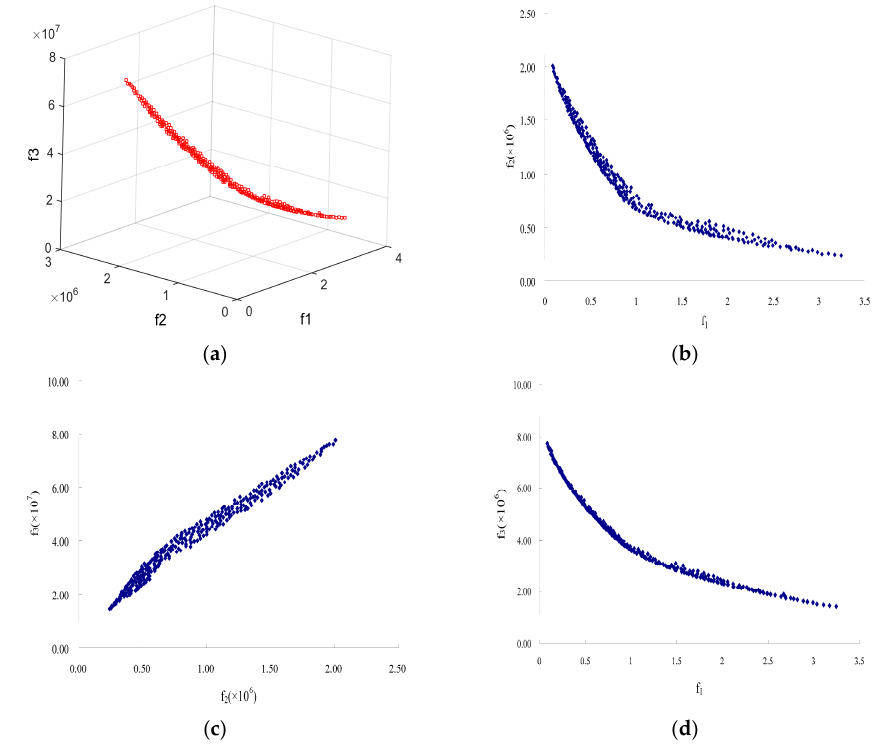
Figure 2. ( a ) The Pareto frontier obtained by multi-objective particle swarm optimization (MOPSO) for the three-objective water resources allocation model; Relation between objectives of the Pareto frontier for the water allocation model: ( b ) f 1 and f 2 ; ( c ) f 2 and f 3 ; ( d ) f 1 and f 3 . ( f 1 —square sum of relative water shortages; f 2 —water supply cost; f 3 —the amount of organic pollutants (COD) in water).